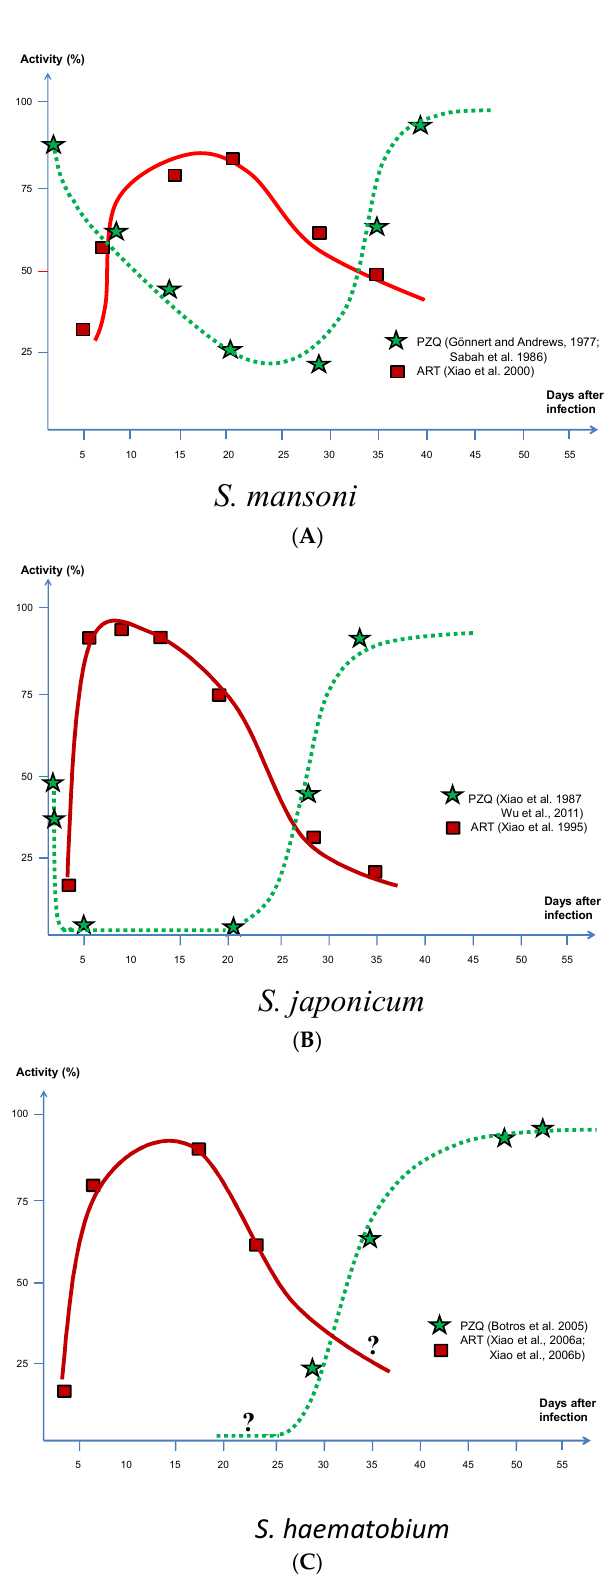
Figure 1. Activity of artemether and praziquantel in relation to different stages of maturity in all three main schistosome species. ( A ) S. mansoni ; ( B ) S. japonicum ; ( C ) S. haematobium .